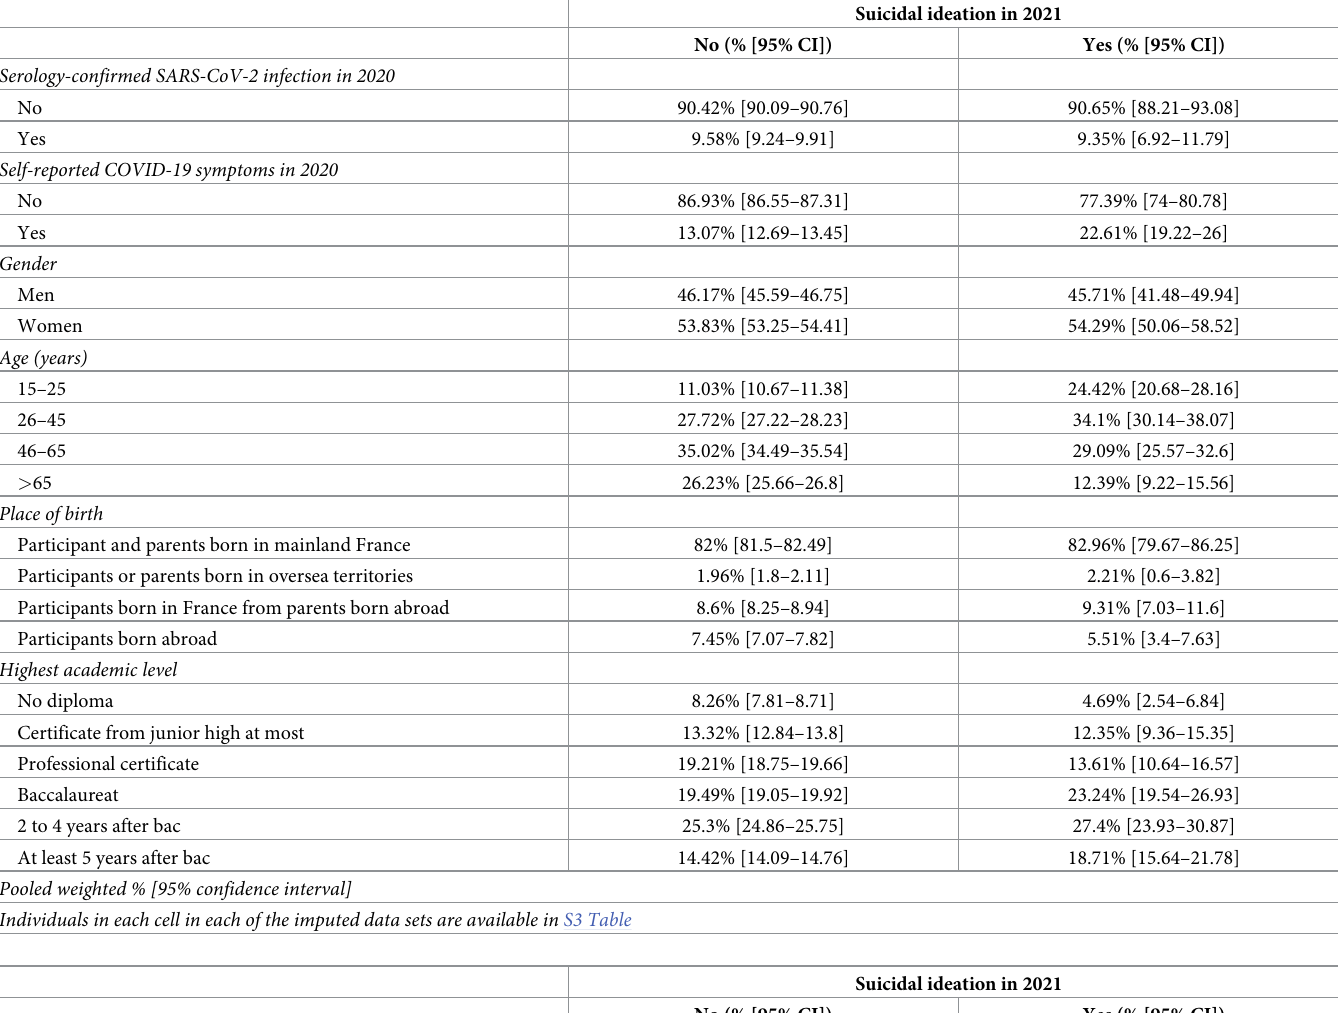
Table 1. Prevalence of exposures and covariates according to suicidal ideation in 2021, weighted by study weights, pooled from five imputed data